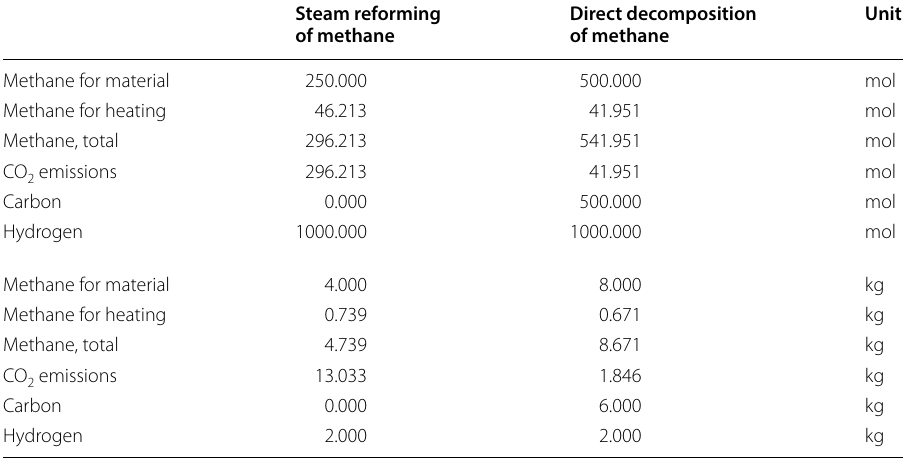
Table 8 Material balance of hydrogen production (by technology). Source : Authors’ calculation Steam reforming of methane